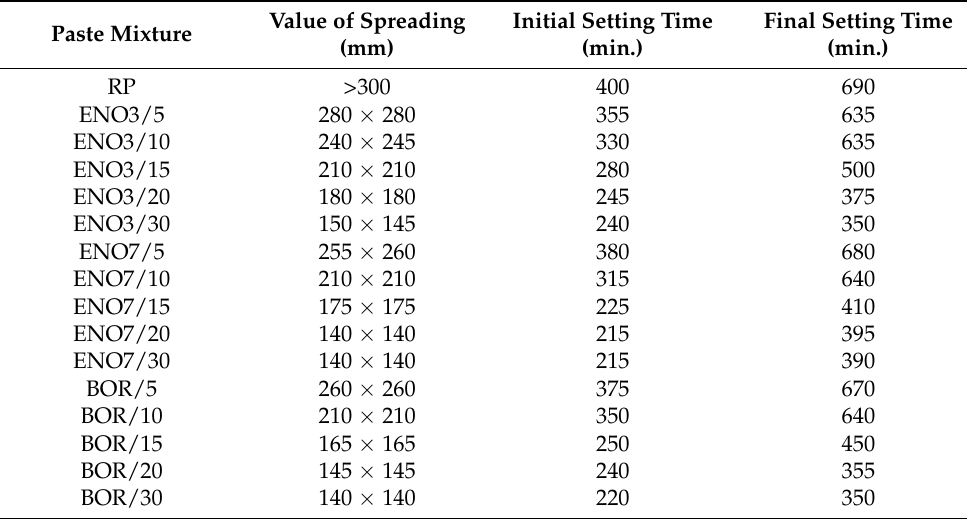
Table 8. The values of spreading and setting time of tested pastes. Paste Mixture